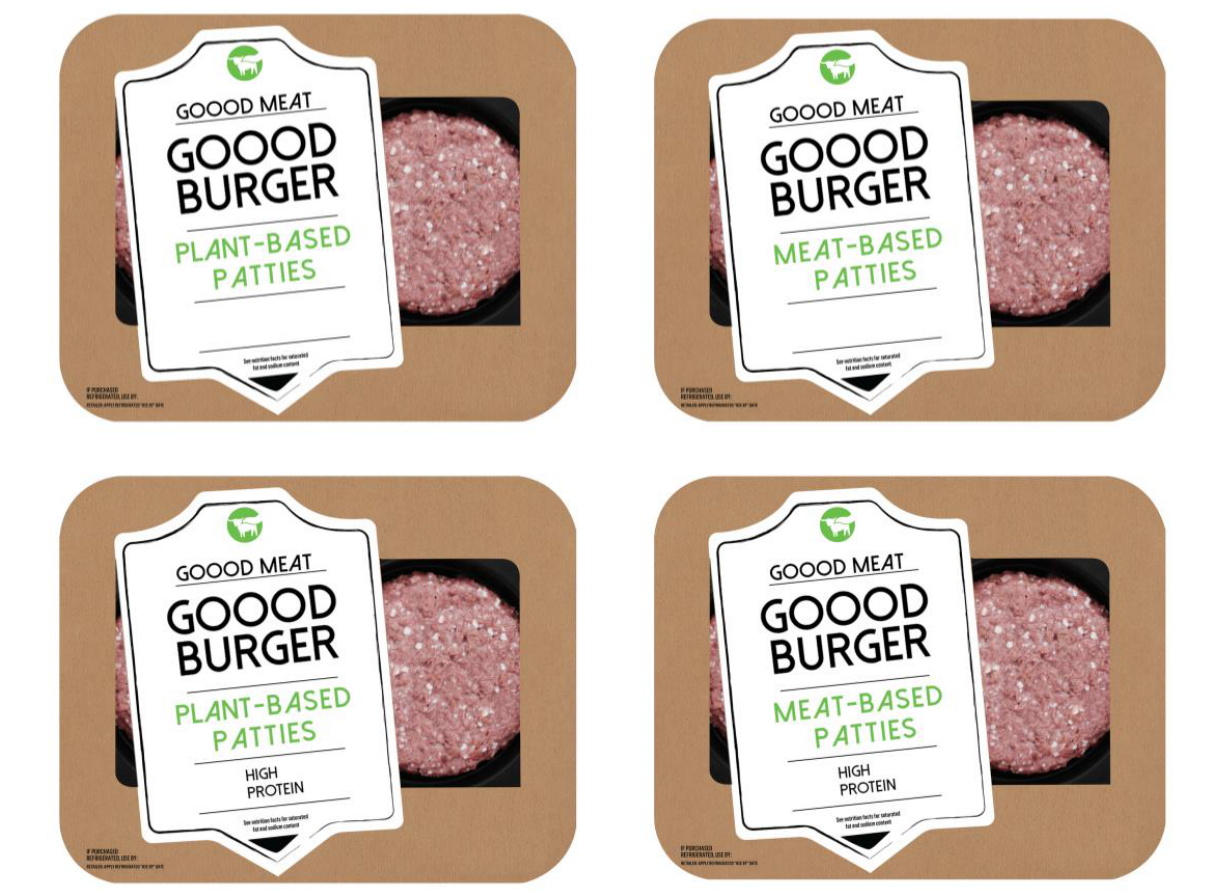
Figure 1. Experimental stimulus.